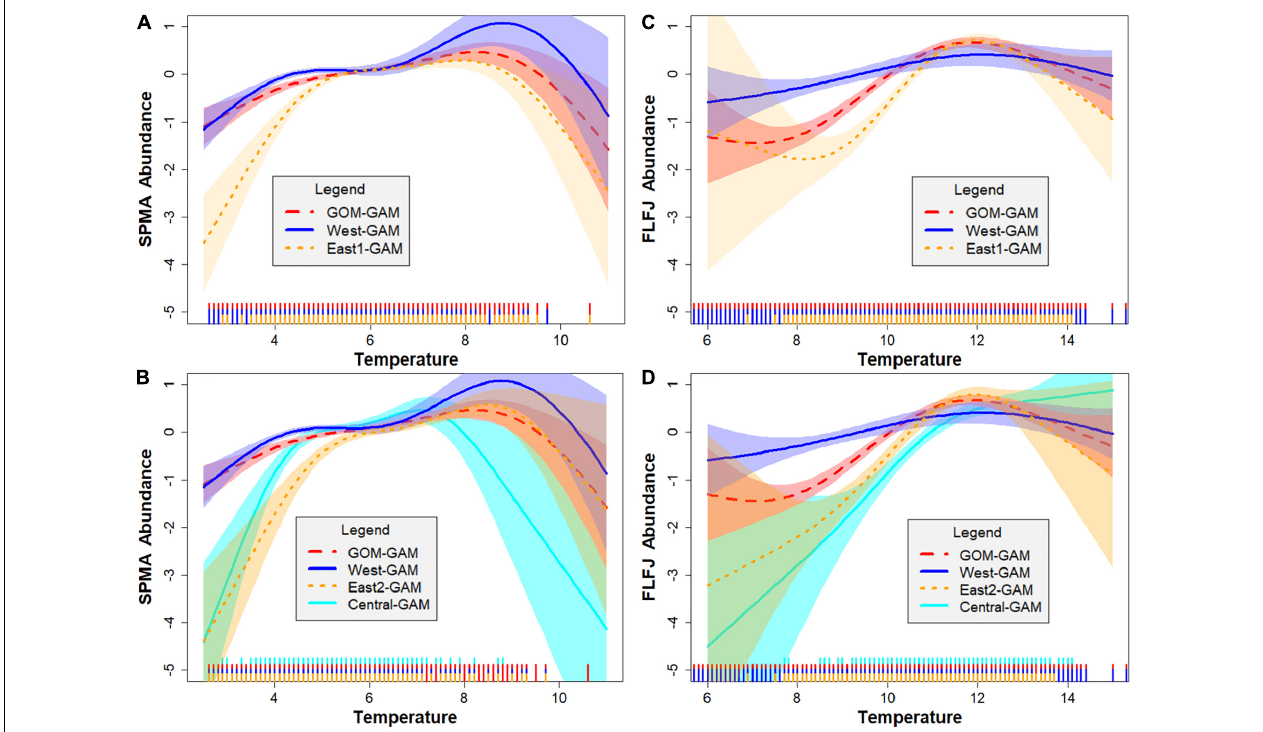
FIGURE 3 | A comparison of spring male adult (SPMA) and fall female juvenile (FLFJ) lobster GAM bottom temperature response curves by spatial location in the GOM. Each plot shows the response curve of bottom temperature ( ◦ C) on the x -axis, against the partial effect of lobster density on the y -axis. Figures (A,C) compare response curves estimated for the GOM–GAM, West-GAM, and East1-GAM, while figures (B,D) compare response curves estimated for the GOM–GAM, West-GAM, Central-GAM, and East2-GAM. Shaded regions on either side of the response curve line indicate the standard error confidence intervals. Rug plot lines along the x -axis of each plot indicate distribution of the bottom temperature data. These response curves were estimated using 2000–2019 ME-NH Inshore Bottom Trawl survey data and are applicable to all years